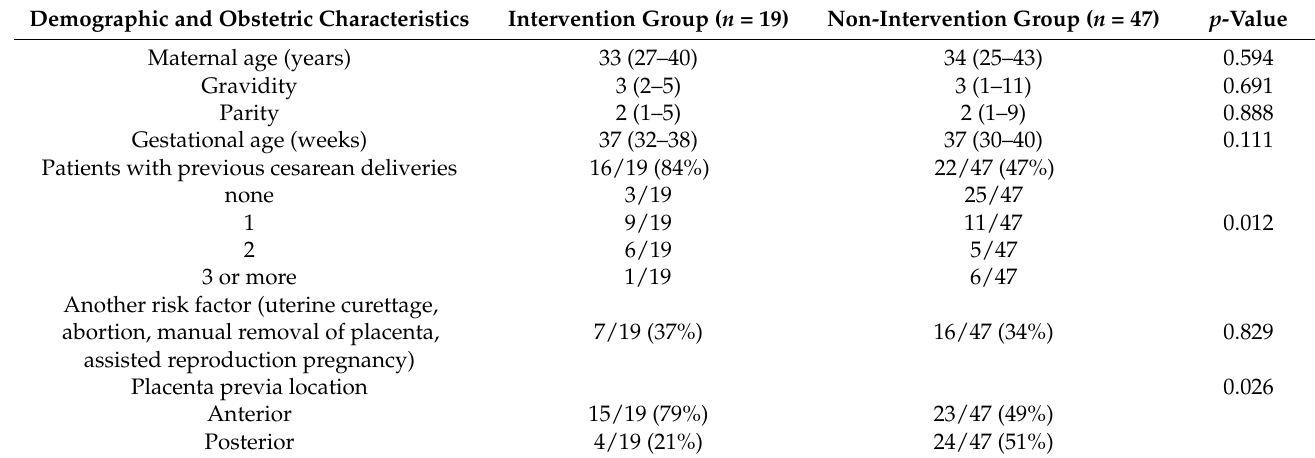
Table 1. Demographic and obstetric characteristics of the